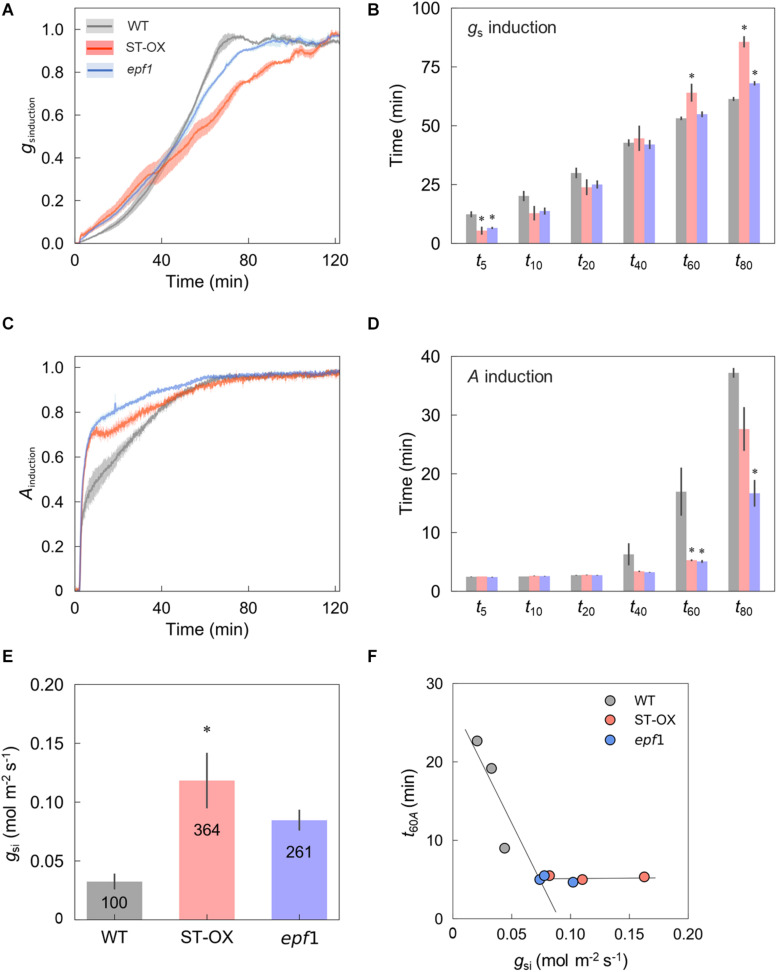
The induction speed of stomatal conductance and CO2 assimilation rate after step increase in light. The induction state of (A) stomatal conductance (gs) and (C) CO2 assimilation rate (A) were evaluated in the three lines of Arabidopsis based on gsinduction and Ainduction defined as Eqs. 1 and 2, respectively, under a PPFD of 500 μmol photon m–2 s–1 for 120 min after the dark period for 10 min. The time when (B)
gsinduction and (D)
Ainduction reached 5, 10, 20, 40, 60, and 80% (t5–80gs and t5–80A) of those maximum values was compared between WT and each transgenic line. (E) The steady-state value of gs under the dark condition (gsi) was compared between WT and each transgenic line. (F) The relationship was investigated between gsi and t60A. Vertical bars indicate the standard error (n = 3). *indicates significant differences in each parameter between WT and each transgenic line at p < 0.05, according to Dunnett’s test. The values in each column represent the relative value of each line to WT.